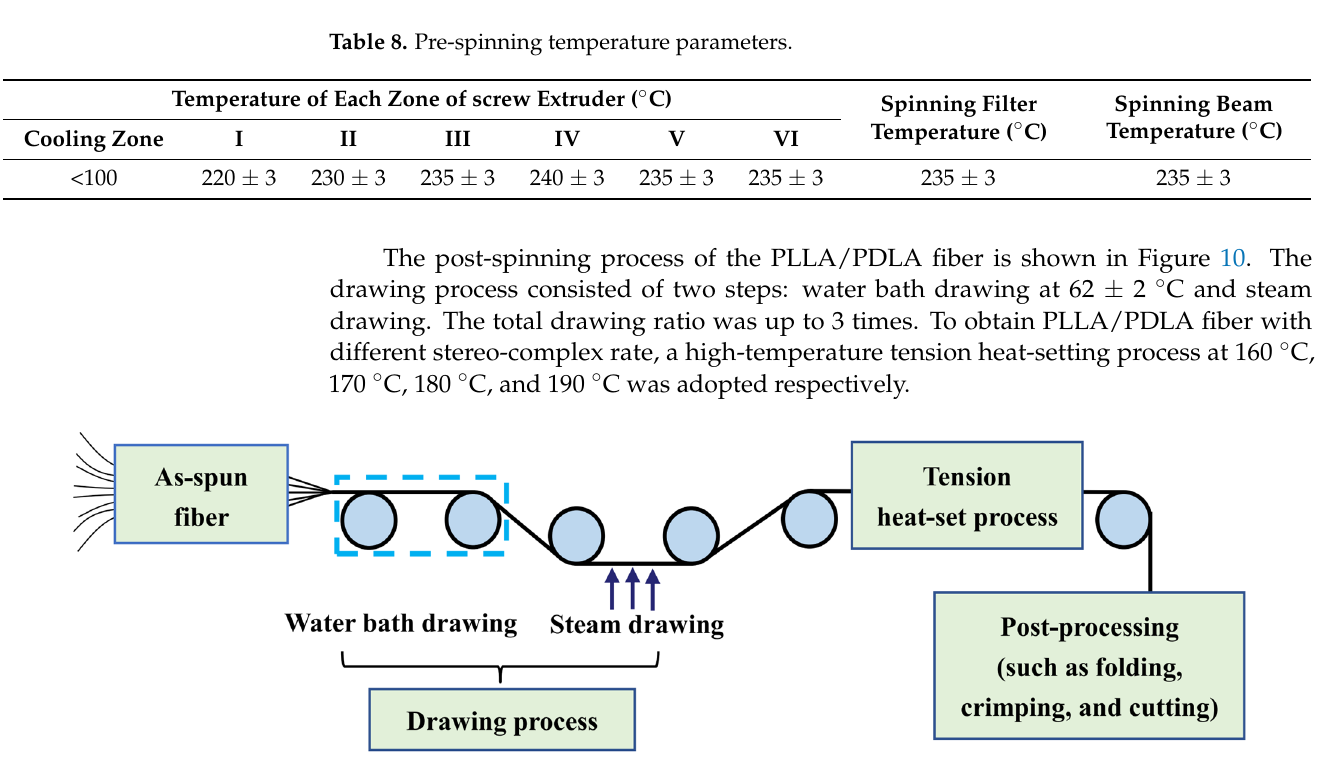
Figure 10. Flow chart of post-spinning process of PLLA/PDLA